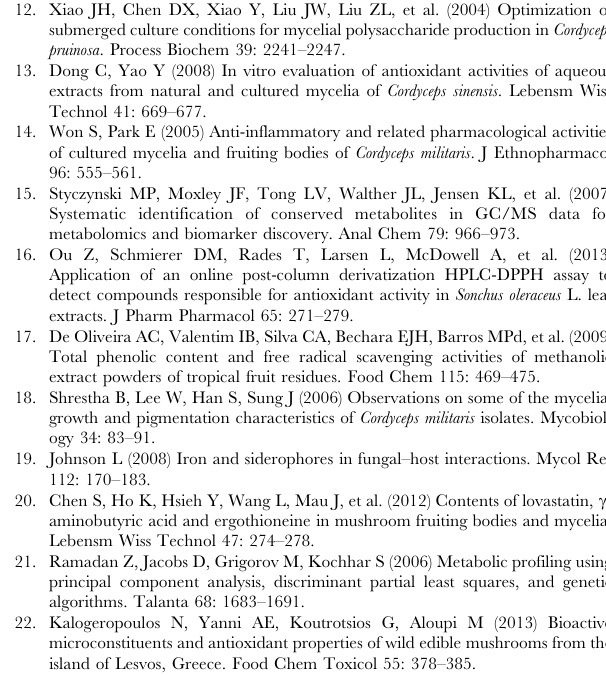
Figure S1 Representative 1 H- 13 C HSQC NMR spectra of Cordyceps pruinosa mycelia by D 2 O extraction. (a) 1 H chemical shift of 0–3 ppm, (b) 1 H chemical shift of 3–6 ppm (1: isoleucine, 2: leucine, 3: valine, 4: threonine, 5: alanine, 7: lysine, Figure S2 PCA loading plots derived from NMR analy- sis of D 2 O extracts of C. pruinosa mycelia cultivated under various conditions.